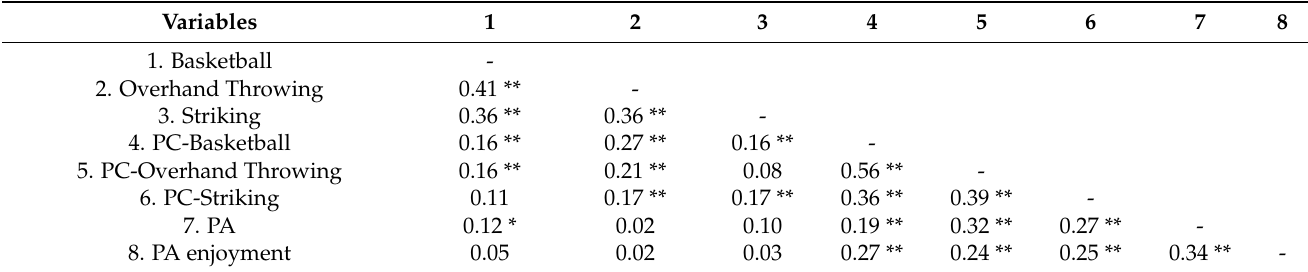
Table 2. Correlations among the study variables (N =